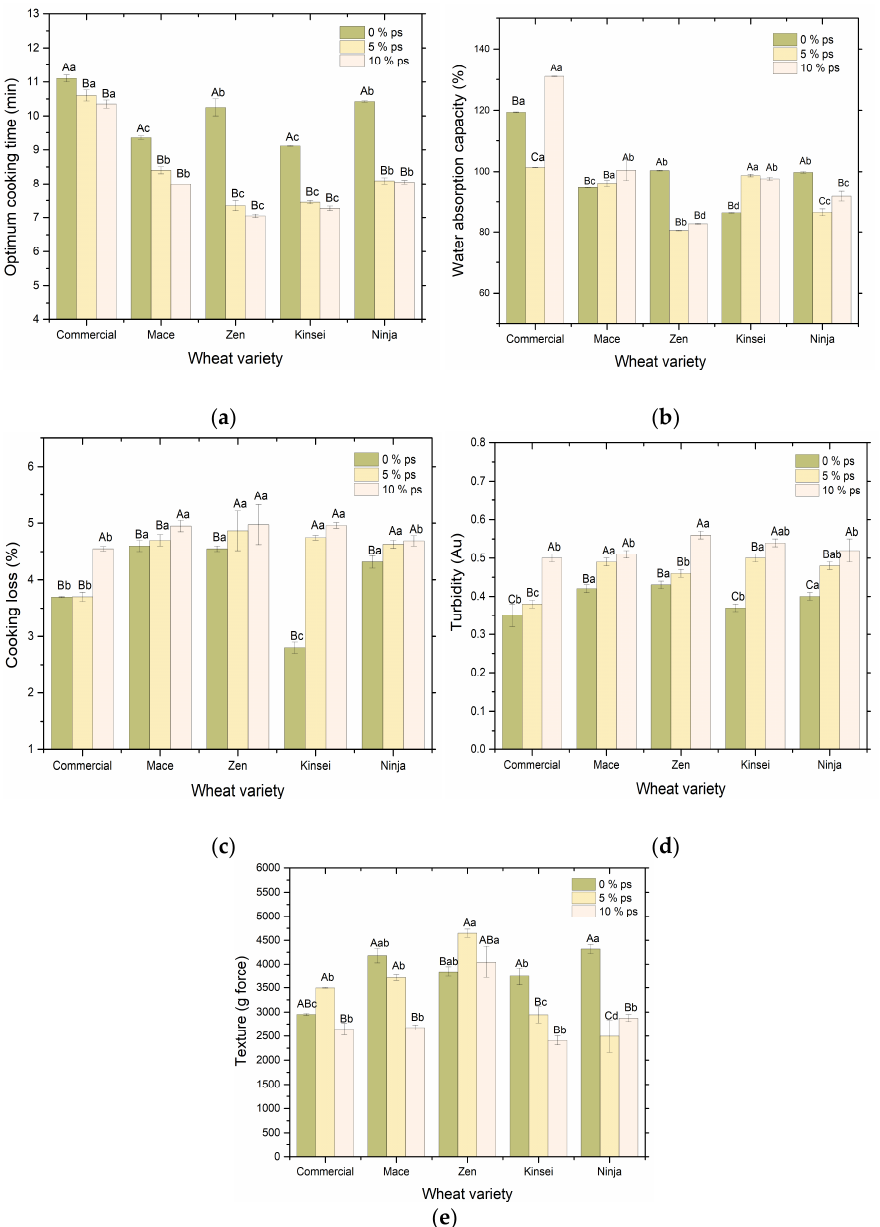
Figure 2. Figures showing the ( a ) optimum cooking time, ( b ) water absorption capacity, ( c ) cooking loss, ( d ) turbidity, and ( e ) texture of noodles prepared from different wheat varieties blended